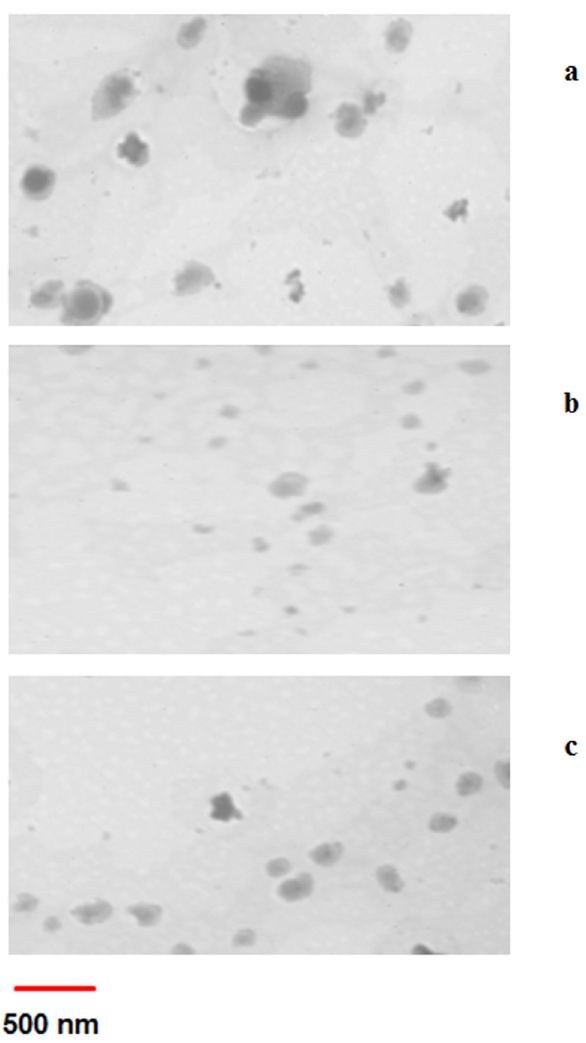
Figure 5: Typical TEM images of the fabricated Au NPs ( a ) , Ag NPs ( b ) and Se NPs ( c ) using co ff ee bean